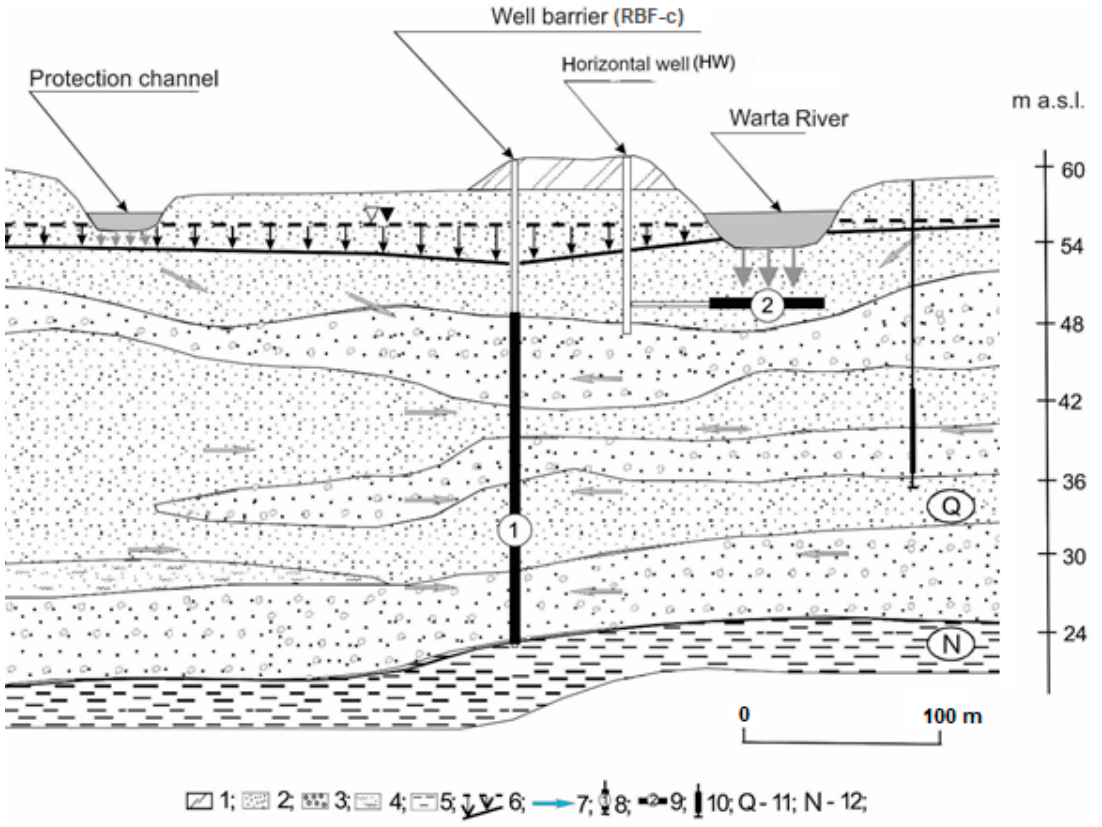
Figure 3. A scheme presenting the location of the horizontal drains of the collector well and positions of the RBF-c wells [20]. Legend: 1—the embankment; 2—sands; 3—gravels; 4—silts; 5—clays; 6—the static and dynamic water level; 7—groundwater flow directions; 8—the position of the RBF well screen; 9—the position of the HW drains; 10—other observation wells; 11—Quaternary; 12— Neogene.